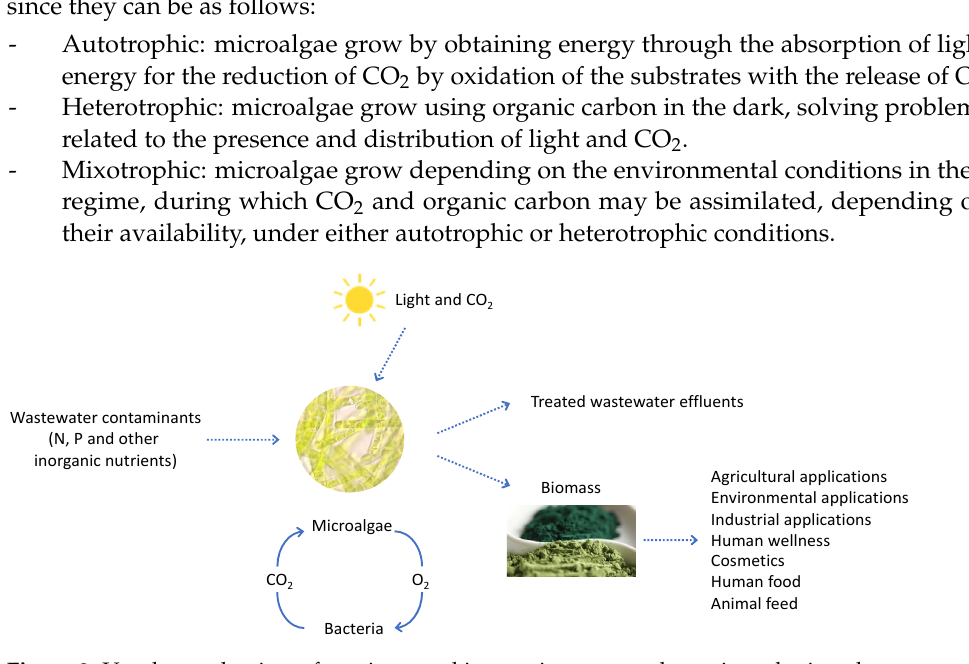
Table 2. Removal rates by microalgae of pollutants in wastewaters of different sources. Microalgae